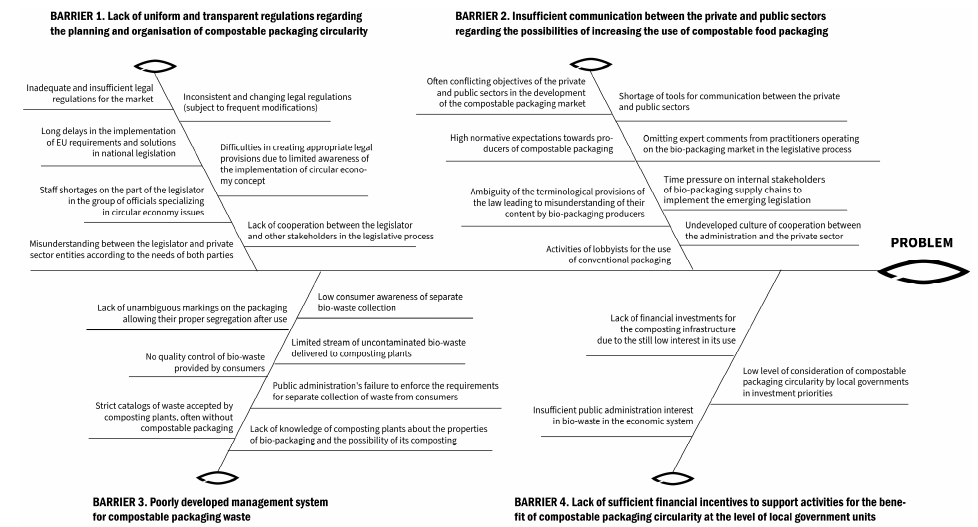
Figure 2. Diagram of the problem–barriers–causes triad. Source: own elaboration based on the SIL workshop 2 results.